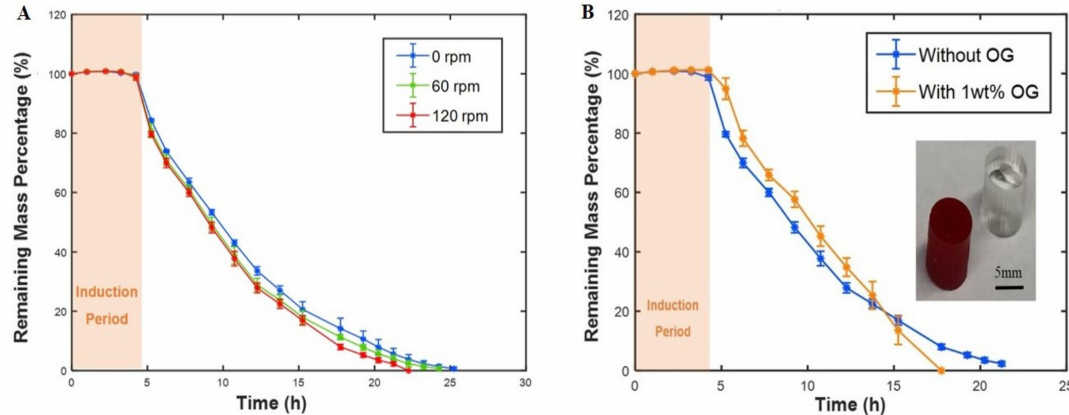
Figure 6. (A ) Mass transfer e ff ect on the polymer mass loss profile. Di ff erent shaking rates (0, 60, 120 rpm) were used. ( B ) E ff ect of adding the model compound to the polymer on mass loss profile. All experiments were conducted at 37 ◦